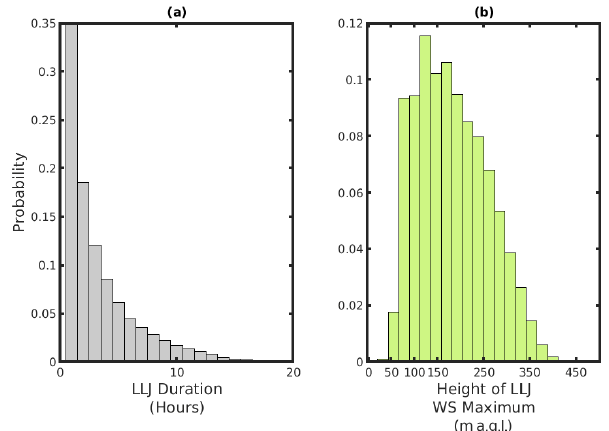
Figure 4. Probability distributions from a domain-wide sample of all hourly realizations of vertical LLJ wind speed (WS) profiles for (a) LLJ duration and (b) height of the jet core. Note that LLJs with durations of over 20h were identified, but the distribution is trun- cated at 20h for legibility.